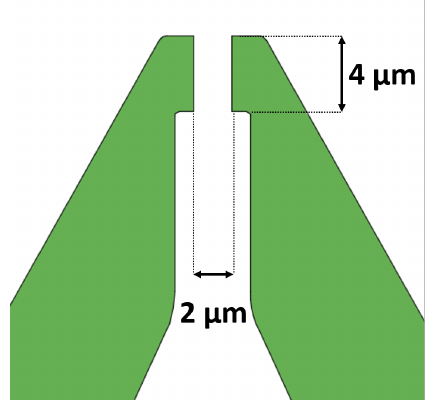
Figure 3. Gripper’s